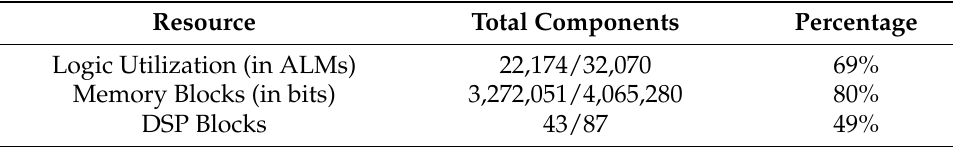
Table 1. Resource utilization of eSoc-LAM hardware modules.